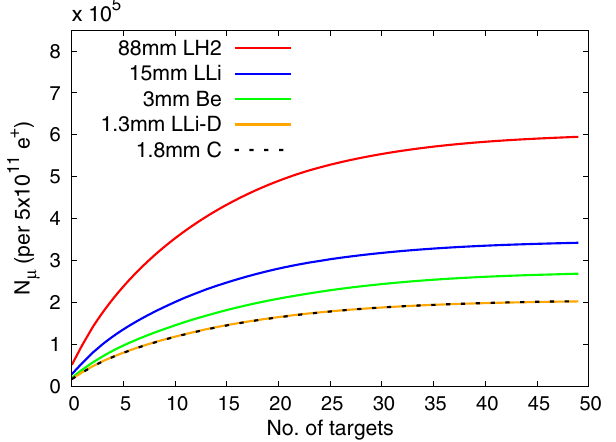
FIG. 8. Muon beam population N μ vs number of targets, 1% X 0 each, for several materials: liquid hydrogen (LH2), liquid lithium (LLi), beryllium (Be), a combination of 10% liquid lithium and 90% diamond powder (LLi-D), and carbon (C). The positron beam population and energy are 5 × 10 11 and 44 GeV, respec- tively.